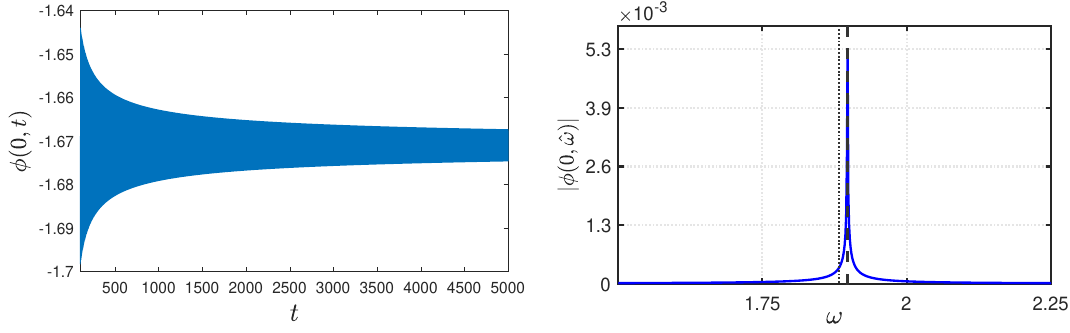
Figure 16 . Small kink-antikink collision: a) Oscillations of the figure 15b up to t = 5000; b) Fourier transform the oscillations for 200 < t < 5000. The dashed line corresponds to the threshold of the continuum modes. In both figures, r = 0 . 1 and v = 0 . 8.